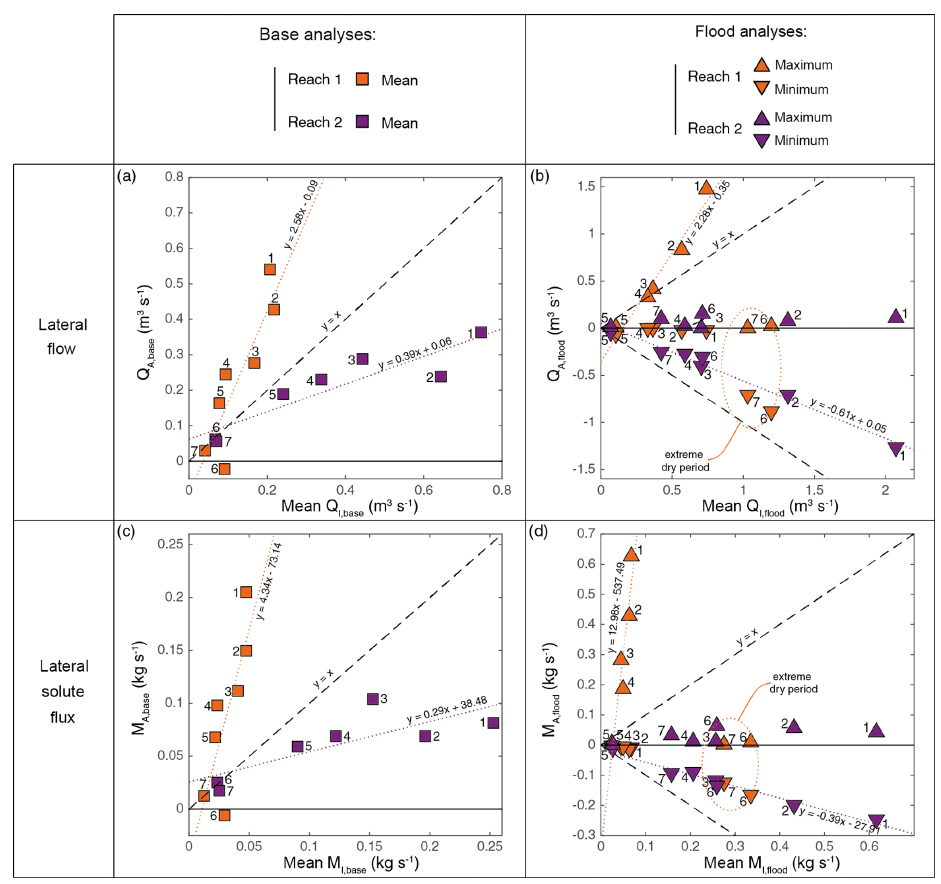
Figure 7. Base and flood analyses of the selected event set. Orange and purple symbols correspond to the lateral-exchange modelling along R1 and R2, respectively. Base analysis is performed on mean values ( (cid:3) ) exclusively whereas flood analysis takes into account minimum ( (cid:96) ) and maximum ( (cid:52) ) values of the calculated lateral exchanges ( Q A, flood and M A, flood ). Base (a) and flood (b) lateral flow ( Q A, base and Q A, flood ) are compared to the mean base and flood flow input ( Q I , base and Q I , flood ) and base (c) and flood (d) lateral solute fluxes ( M A, base and M A, flood ) are compared to the mean base and flood fluxes input ( M I , base and M I , flood